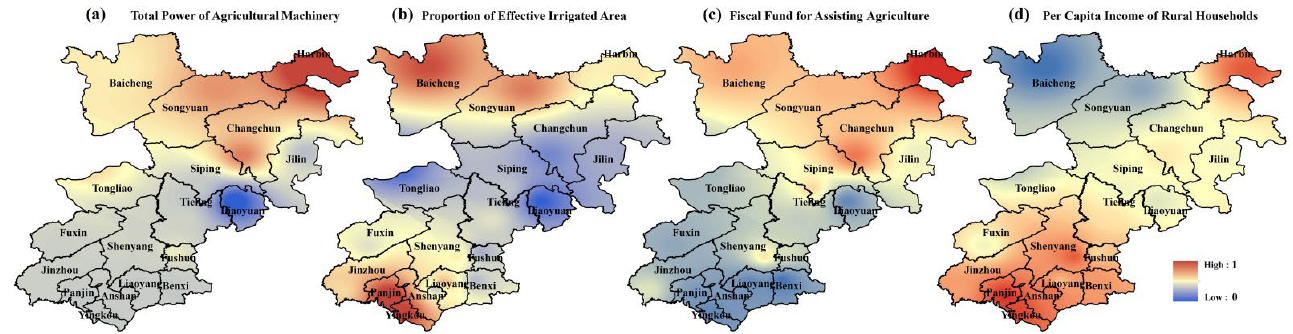
Figure 8. Spatial distribution of factors influencing drought vulnerability in the Songliao Plain.